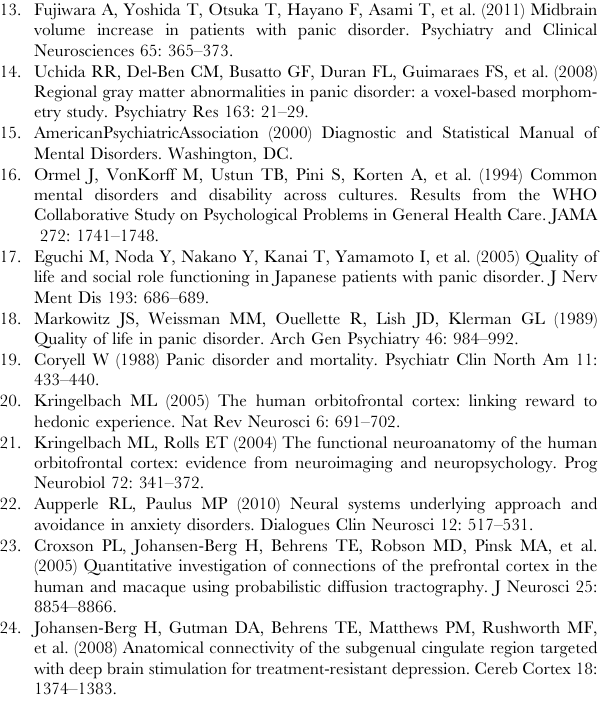
Figure S1 White matter volume reductions in the patients with panic disorder compared with the healthy control subjects. Glass brain pictures show white matter volume reductions in the 40 patients with panic disorder compared with the 40 healthy control subjects. Uncorrected p , .001 with an extent threshold of 40 voxels was used for graphical reporting, and all the regions shown as volume reductions also satisfied the False Discovery Rate criterion with a corrected P , .05. Abbreviations: A, anterior; P, posterior; R, right; L,